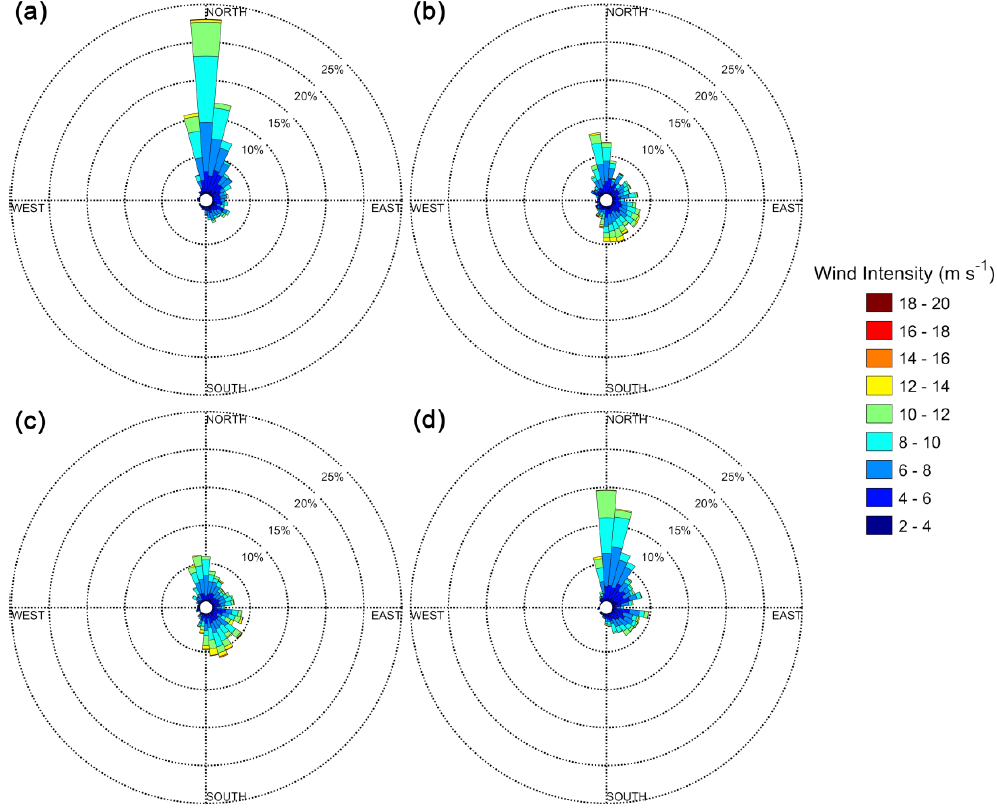
Figure 6. Frequency histogram of daily surface wind magnitude and direction for the study area: austral summer ( a ), autumn ( b ), winter ( c ), and spring ( d ).